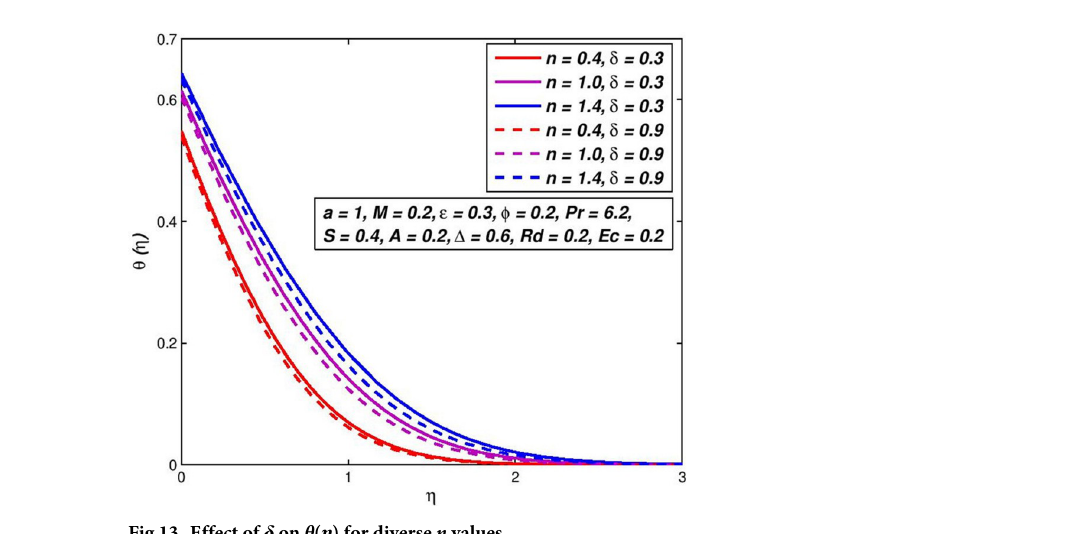
Fig 13. Effect of δ on θ ( η ) for diverse n values.